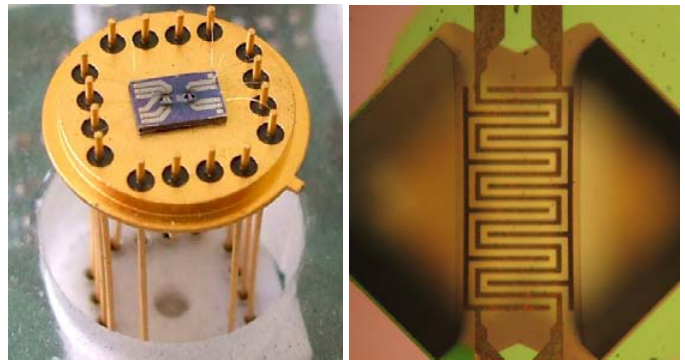
Figure 4. Image of the device, once micromachined platform has been bonded to TO package ( left ). A detail of gas sensing region of the platform is also shown ( right ): the greenish area is the active nanoporous layer (in this case,